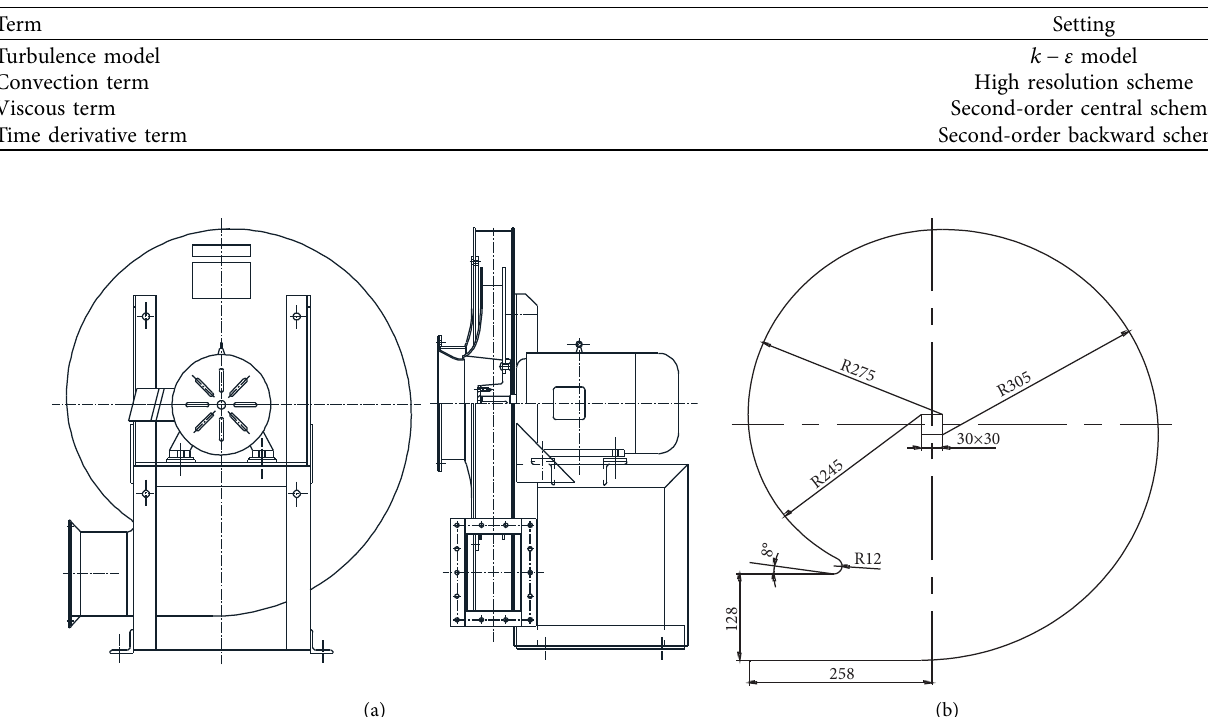
Table 1: CFD calculation parameter setting.